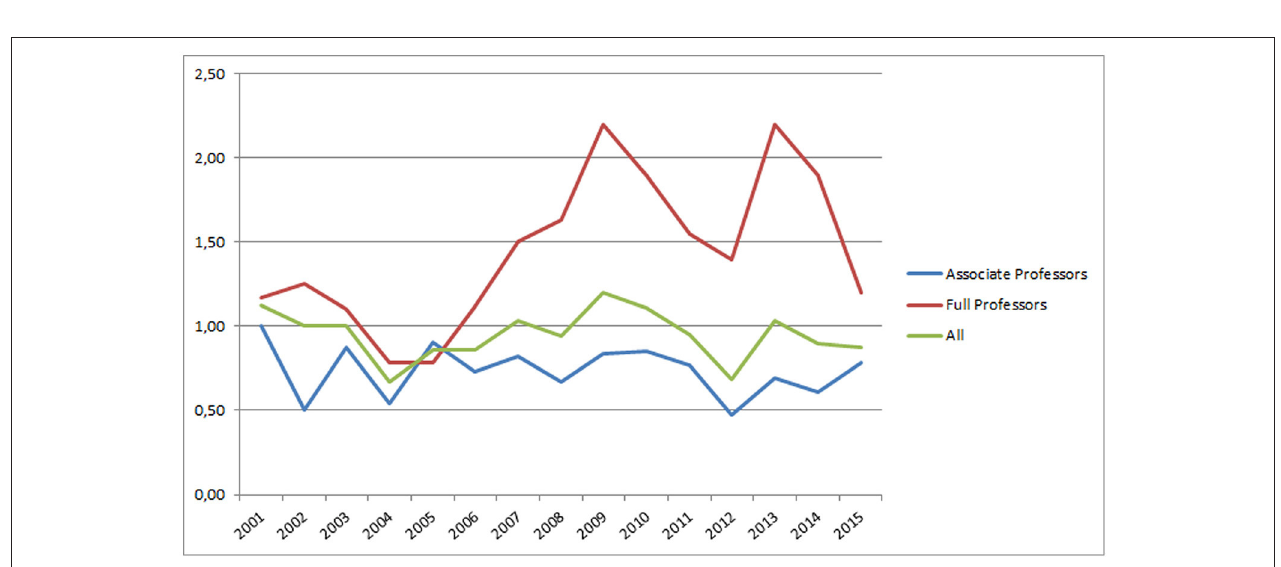
FIGURE 2 | Evolution of scientific activity (average articles per year) of associate professors and full professors in the Web of Science category “Infomation Science and Library Science”